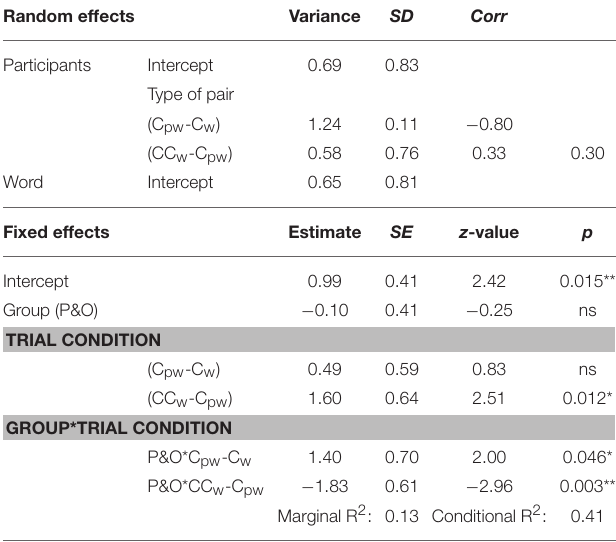
TABLE 3 | Results of mixed-model analysis of the effects of group (Phonology, Phonology & Orthography) and type of pair (CC pw -C w , C pw -C w , CC w -C pw ) on mean percentage of correct responses in the rhyme judgment task.